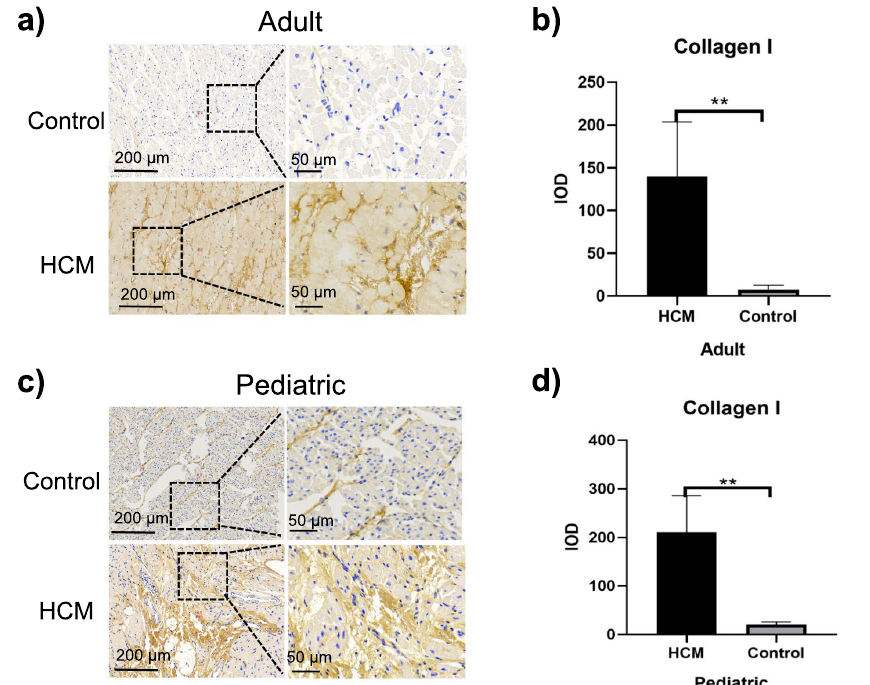
Figure 5. Immunohistochemical analysis of type I collagen expression in ventricular septal myocardial tissue from patients with HOCM. ( a ) Representative images of immunohistochemical staining of type I collagen in ventricular septal myocardial tissue from the control and adult HOCM patients. Scale bars, 200 μm and 50 μm (enlarged views of boxed areas). ( b ) Quantification of type I collagen expression level in ventricular septal myocardial tissue from the control and adult HOCM patients. Data are mean ± SEM, ** p < 0.01. ( c ) Representative images of immunohistochemical staining of type I collagen in ventricular septal myocardial tissue from the control and pediatric HOCM patients. Scale bars, 200 μm and 50 μm (enlarged views of boxed areas). ( d ) Quantification of type I collagen expression level in ventricular septal myocardial tissue from the control and pediatric HOCM patients. Data are mean ± SEM, ** p <